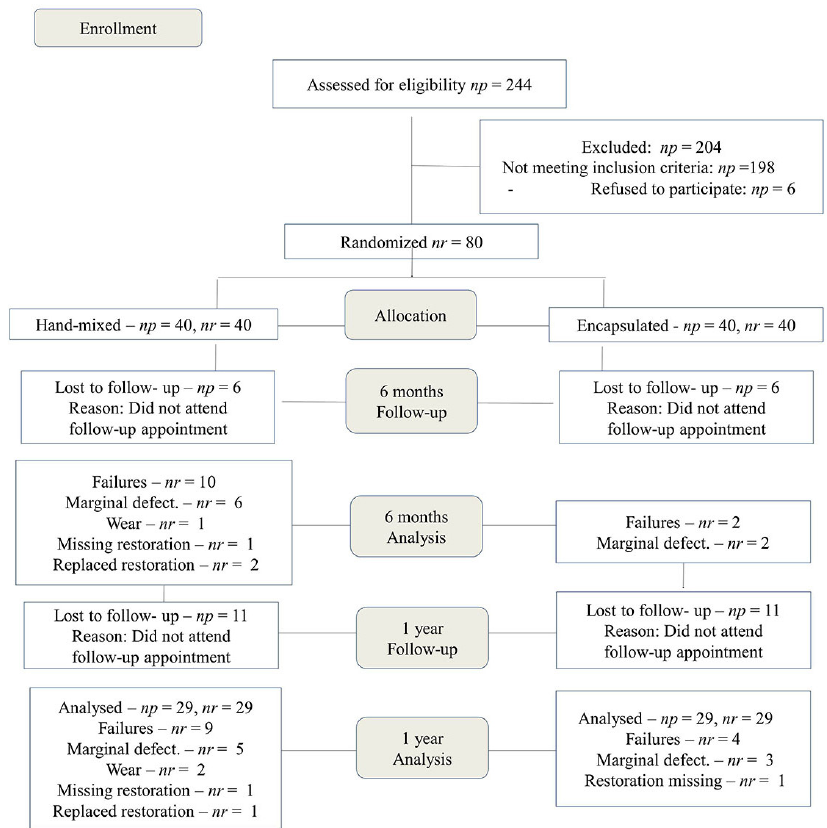
Figure 1- CONSORT participant flowchart. np=number of patients; nr=number of